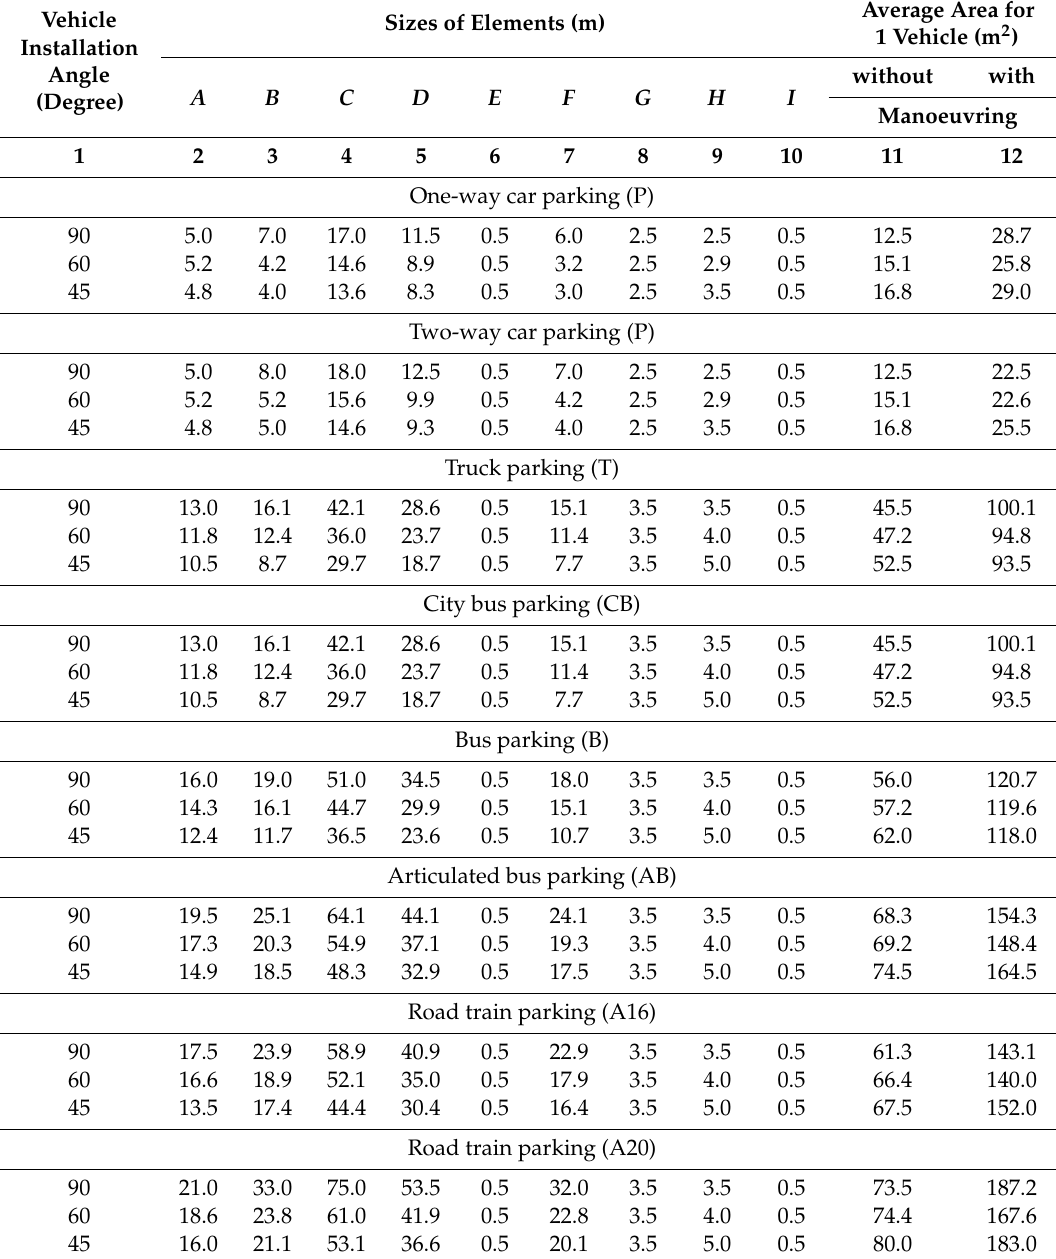
Table 3. Size of parking elements and average areas of one parking